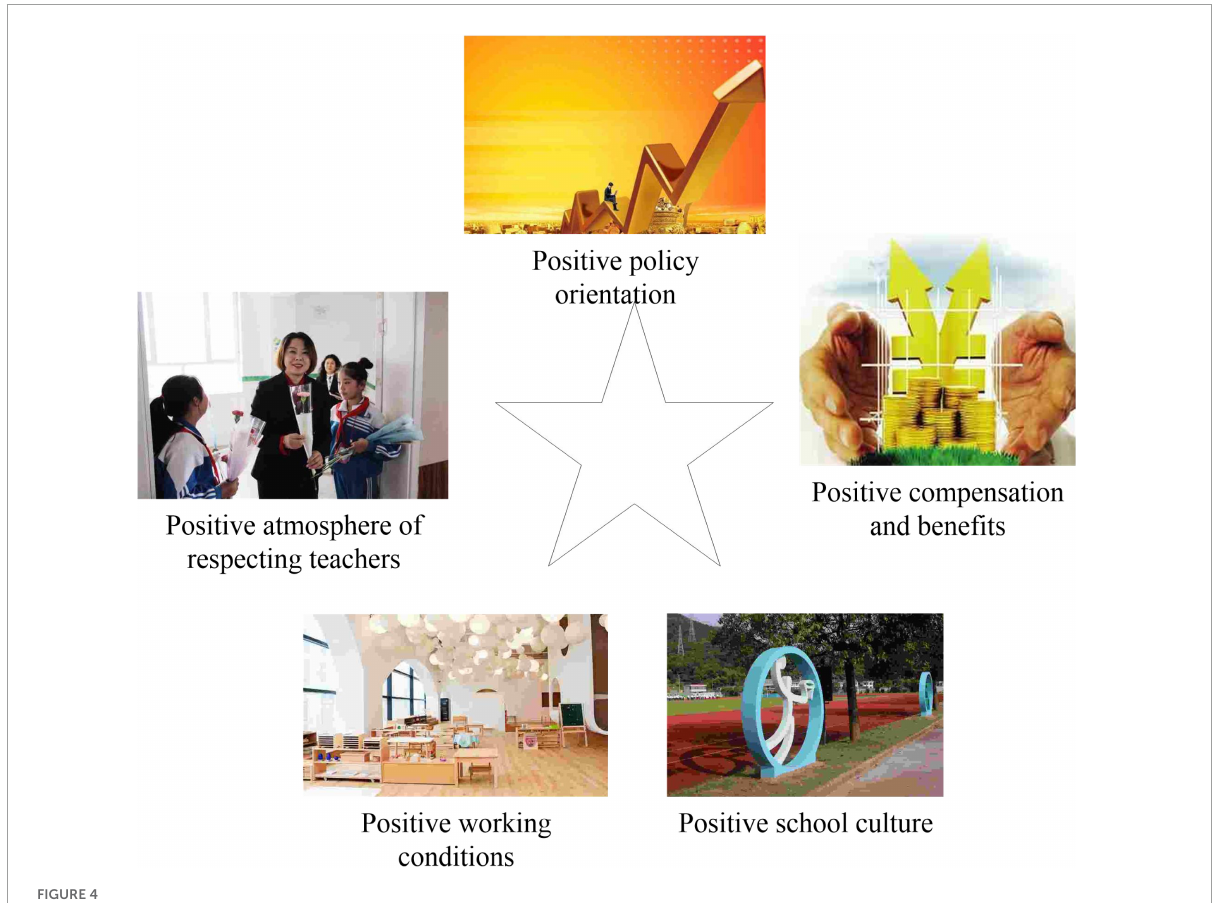
FIGURE4 Psychological external support